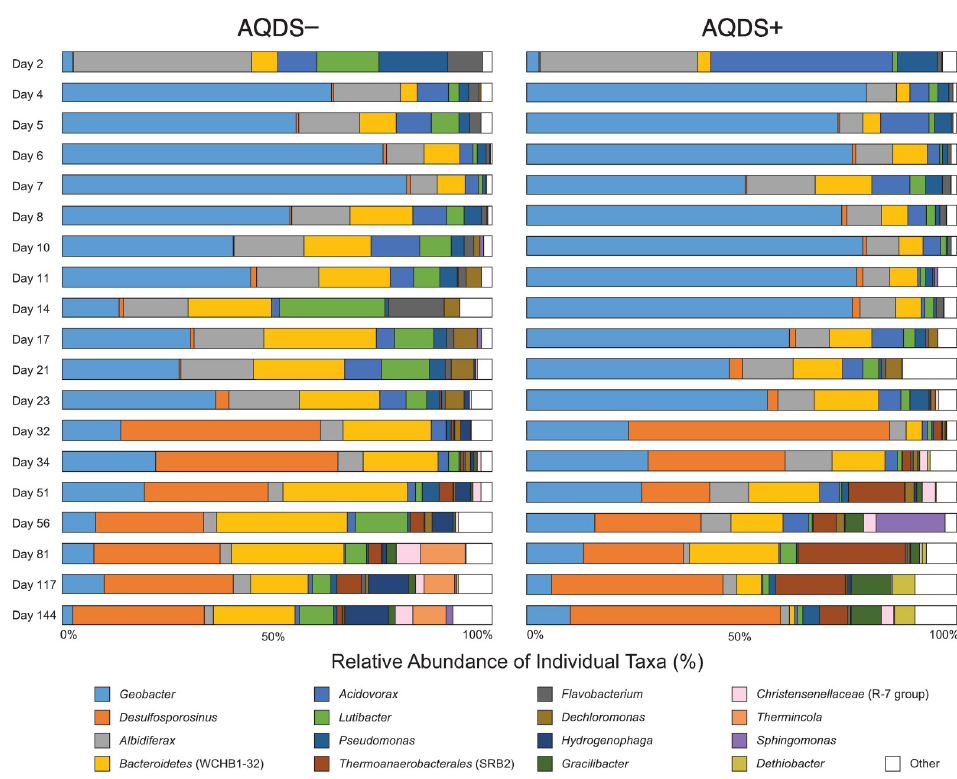
Fig 5. Changes in the relative abundance of microbial taxa over time. Comparison of the relative abundance of individual taxa detected by 16S rRNA gene amplicon sequencing in bioreactors amended with natural goethite, sulfate, and acetate in the presence (AQDS+) or absence (AQDS − ) of the electron shuttle